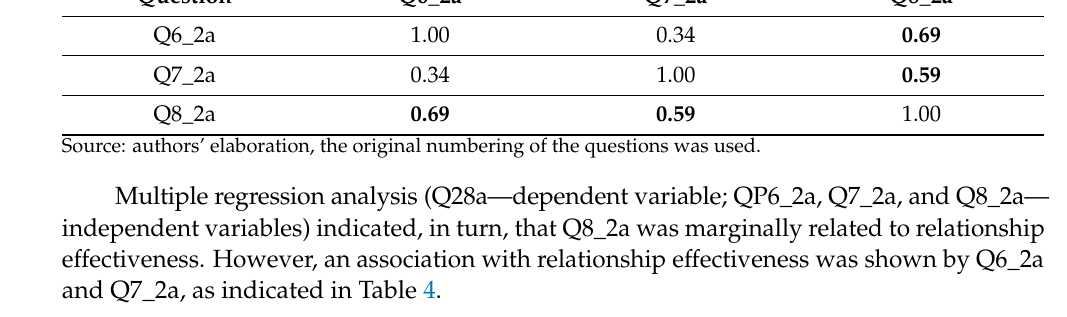
Table 4. Multiple linear regression coefficients for Q28a vs. Q6_2a, Q7_2a, and Q8_2a. Explanatory Variable